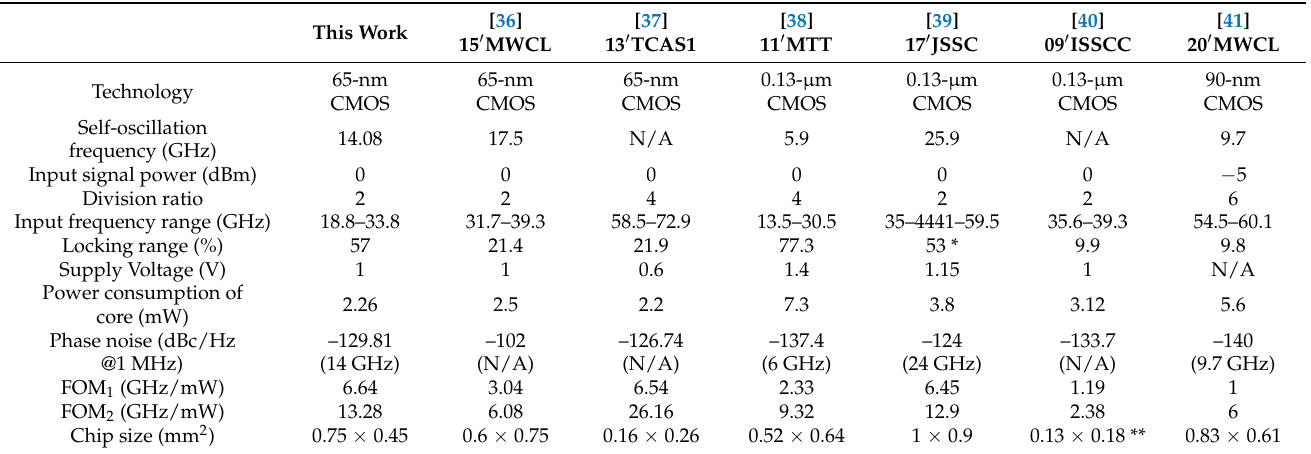
Table 3. Performance comparison of mm-Wave